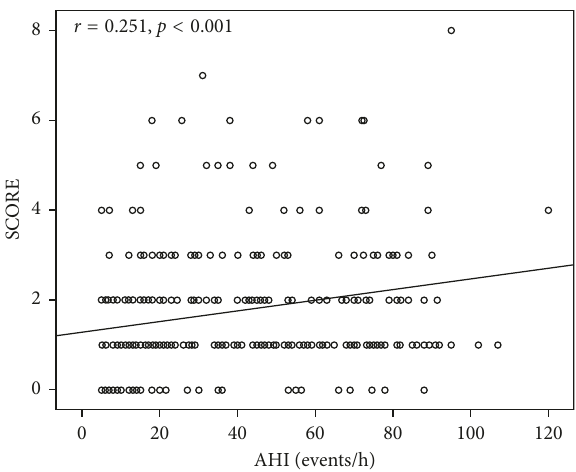
Figure 3: Correlation between Systematic Coronary Risk Evalu- ation score (SCORE) and apnea-hypopnea index (AHI) in ob- structive sleep apnea syndrome patients.